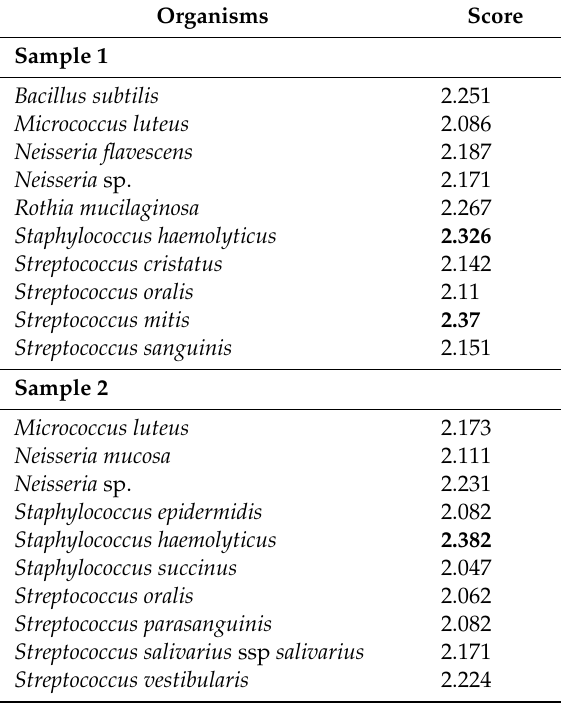
Figure 6. Images of blood agar plates into which the Ti-Zr discs had been repeatedly pressed. The plates have been incubated for 24 h at 37 °C. Table 2. Microorganisms isolated from the roughened surface of untreated and double diamond electrode (DDE)-treated Ti-Zr discs. Identification was performed via MALDI-ToF analysis (bold numbers indicate a Score > 2.3 = highly probable species identification, Score > 2.0 = secure genus, probable species identification).